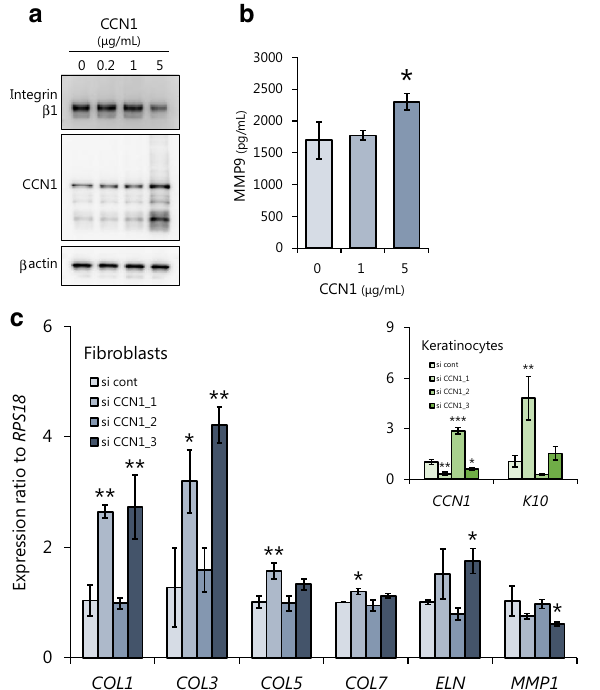
Figure 3. Secreted CCN1 from keratinocytes disrupts the expression of basement membrane and extracellular matrix components. Effects of excess CCN1 on inflammation of the stratum basale. Integrin-β1 and MMP9 expression in keratinocytes treated with human recombinant CCN1 for 48 h determined by western blotting and ELISA, respectively. Full-length gels and blots are included in Supplemental Fig. 6c ( a , b ). Effects of keratinocyte-derived CCN1 on mRNA expression levels of COL1, COL3, COL5, COL7, ELN and MMP1, in fibroblasts determined by qPCR. Three different sequences of siRNAs were used to avoid off-target effects (siCCN1_1-3). ( c ). Values reported are means ± SD of n = 3 replicates, Dunnett’s test, * p < 0.05, ** p < 0.01, *** p <